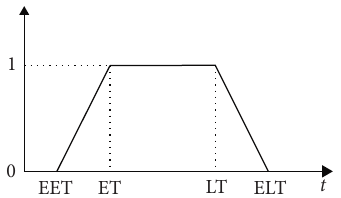
Figure 1: Fuzzy gradient function of customer